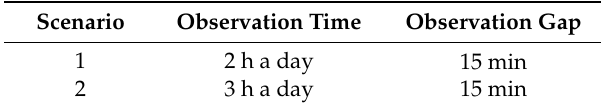
Table 5. GK-2B orbit determination (OD) scenario.